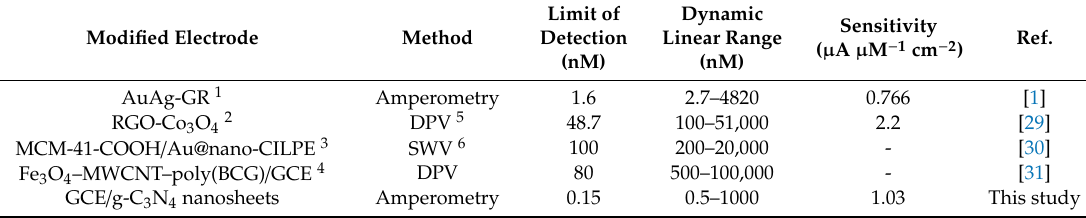
Table 1. Comparison of the prepared sensor with previously reported studies for 5 ‐ HT detection. Modified Electrode